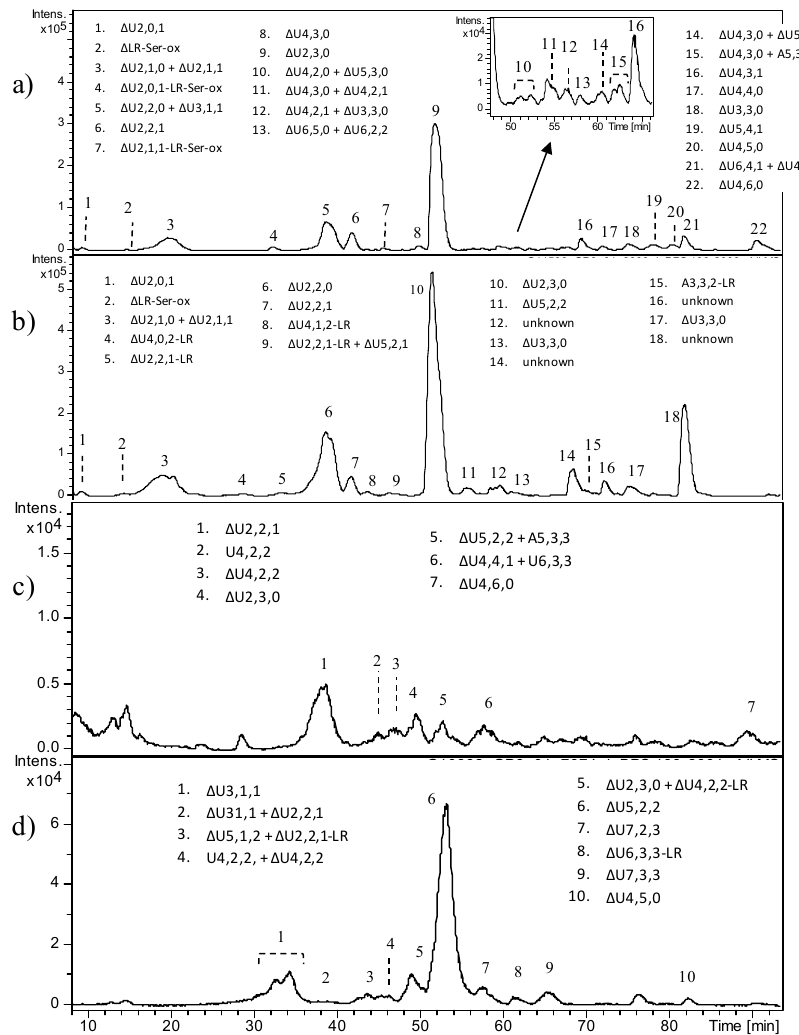
Figure 6. LC–MS profiles of heparinase digestion of HS from osteochondromas: ( a ) OC4-A, ( b ) OC4-B, ( c ) OC5-A, and ( d ) OC5-B. When a uronic acid (or a glucosamine) is present at both the RE and NRE, it is indicated by U (or A). LR indicates the tetrasaccharide G-Gal 2 -Xyl of the linkage region, while LR-Ser-ox indicates also the presence of the oxidized serine residue. Oligosaccharides for which an imprecise interpretation was found were labeled as “unknown”.